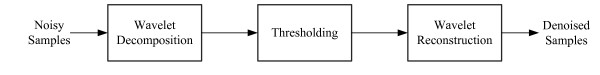
The commonly used thresholding algorithm to remove noise.